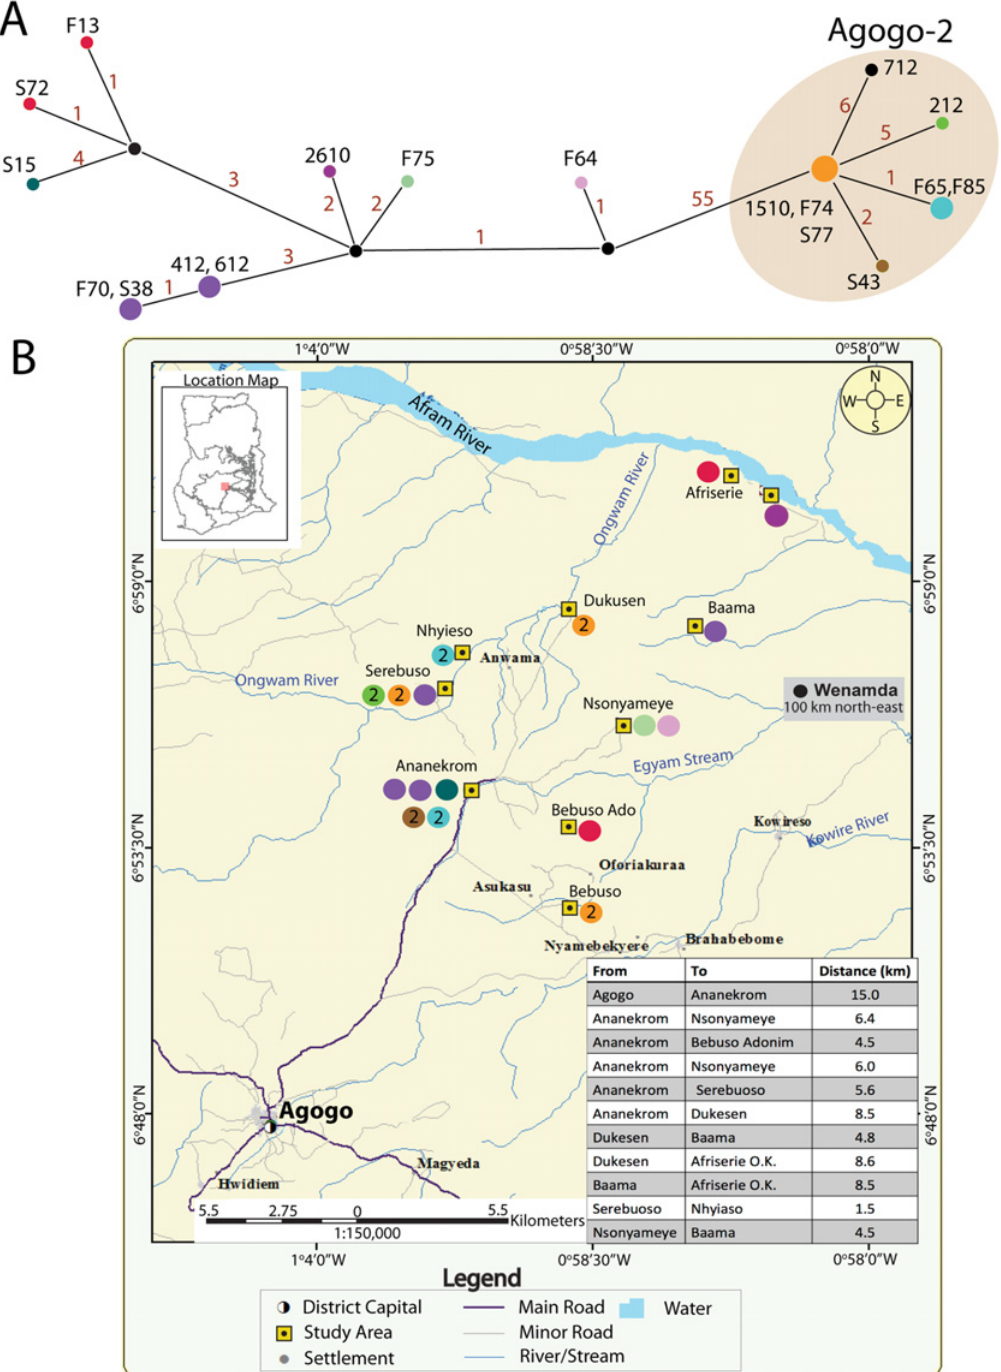
Fig 2. Micromolecular epidemiology of BU in the Asante Akim North District revealed by M . ulcerans whole genome sequence comparisons. (A) Median-joining network graph showing the genetic relationship between 18 M . ulcerans clinical isolates comprising the Agogo-1 and Agogo-2 genotypes (shaded), inferred from whole genome sequence alignments. Node sizes in the graph are proportional to the frequency of genotype occurrence and have been colour-coded accordingly. Edges are labelled in red with the number of mutational steps between each node. (B) Map of Asante Akim North District study area, showing the location of endemic villages and the origin of each of the 18 BU cases, with a coloured circle corresponding with the genotype displayed in the network graph in (A). The number “ 2 ” within some coloured circles indicates an Agogo-2 genotype.